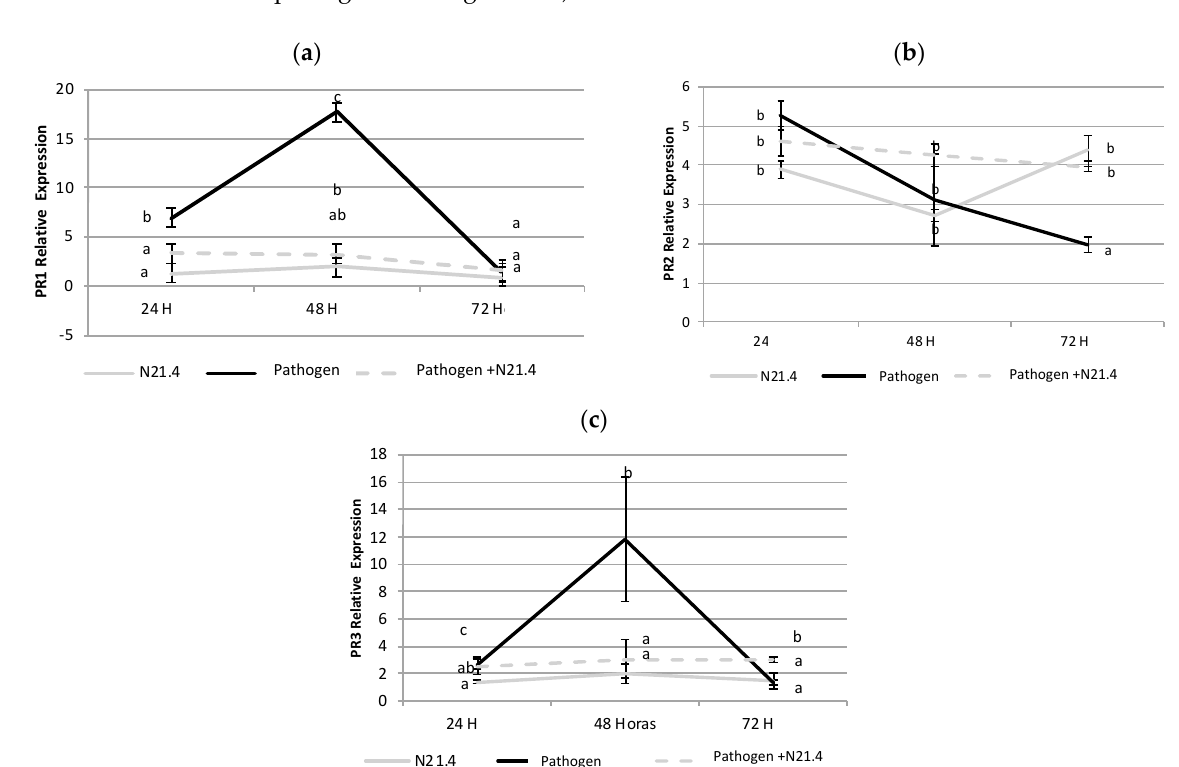
Figure 7. Gene expression of PR proteins (pathogenesis related proteins) of 6-week old tomato plants inoculated with P. fluorescens N21.4 and non-inoculated controls in the priming phase and in the post-challenged priming state after inoculation with the leaf spot pathogen Xanthomonas campestris , sampled at 24 h, 48 h and 72 h after challenge. ( a ) PR1, ( b ) ß-1,3-Glucanase (PR2), ( c ) Chitinase (PR3). N21.4: plants treated with Pseudomonas fluorescens (grey solid line). Pathogen: plants challenged with the leaf spot pathogen Xanthomonas campestris (black solid line). Pathogen + N21.4: plants treated with Pseudomonas fluorescens N21.4 and challenged with the leaf spot pathogen Xanthomonas campestris (grey broken line). Bars indicate standard errors ( n = 3). Different letters indicate significant differences ( α = 0.05) between treatments for each time point.